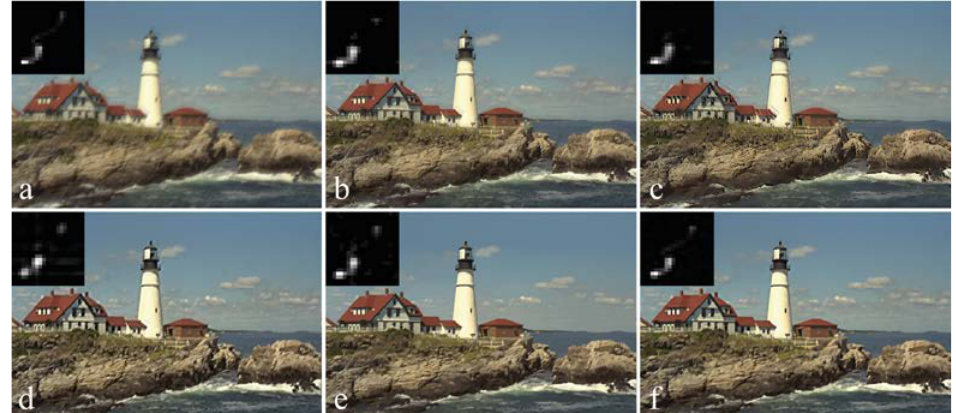
Figure 7. Comparison results for the “Lighthouse.png” image: ( a ) blurry image; ( b ) method in [35]; ( c ) method in [36]; ( d ) method in [37]; ( e ) method in [38]; ( f ) proposed method.